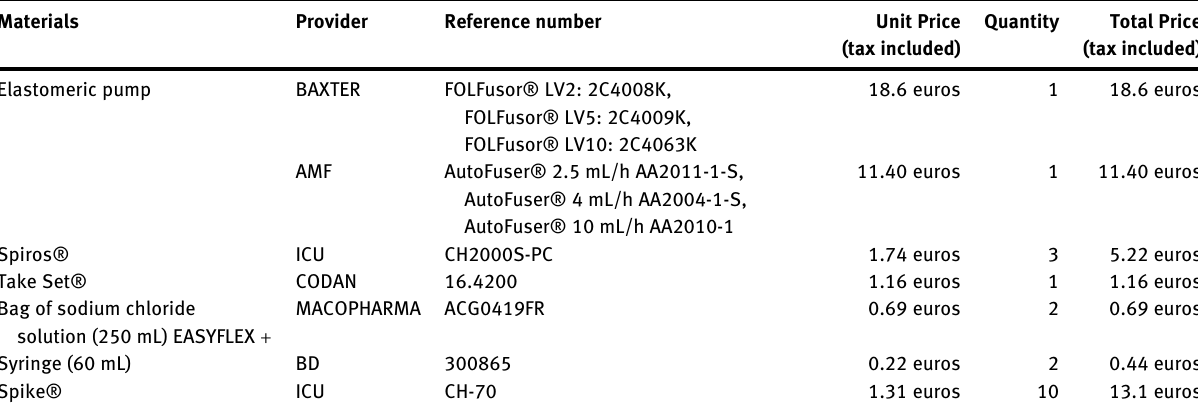
Table  : Materials used for manual preparation of elastomeric pump.